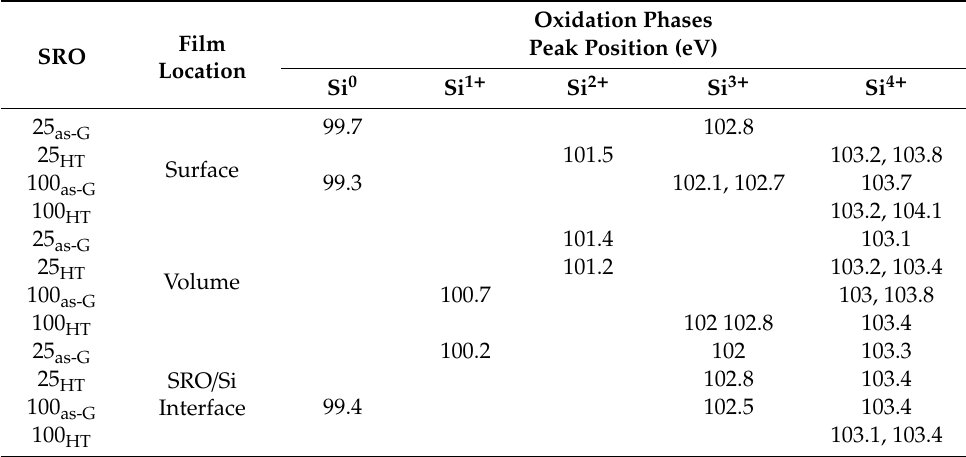
Table 2. Oxidation phases of SRO 25 and SRO 100 single-layer films analyzed by